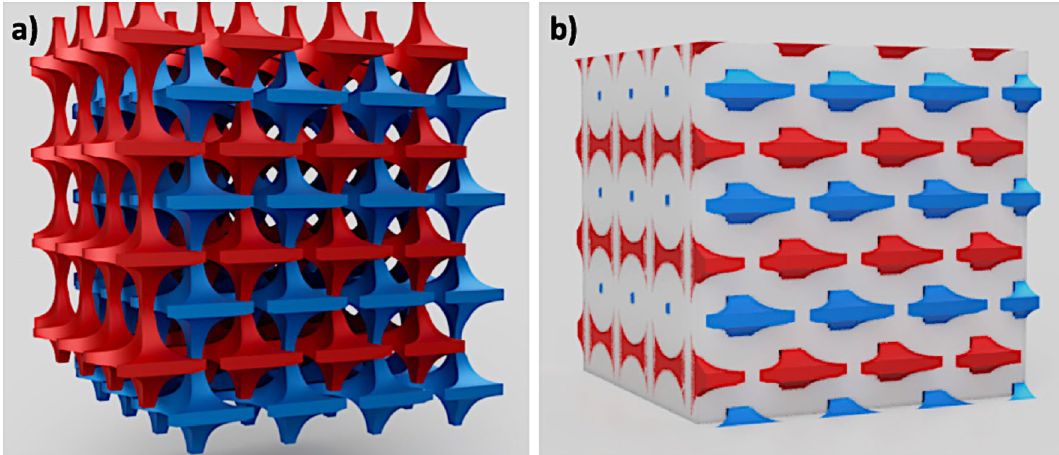
Figure 8. Schematic of a 3D battery architecture that could only be obtained thanks to multi-material printing options: ( a ) without, and ( b ) with the electrolyte displayed (blue: positive electrode, red: negative electrode, white: solid